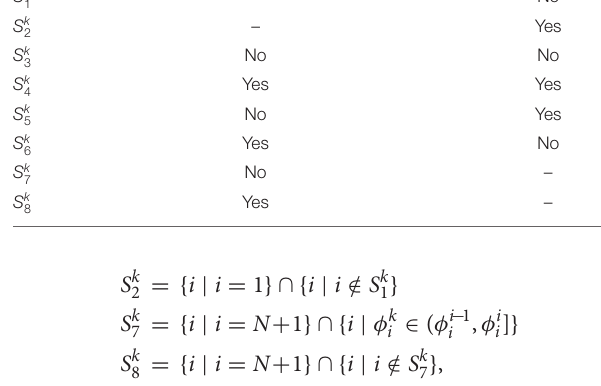
FIGURE 10 | Relation between ˆ ψ k k